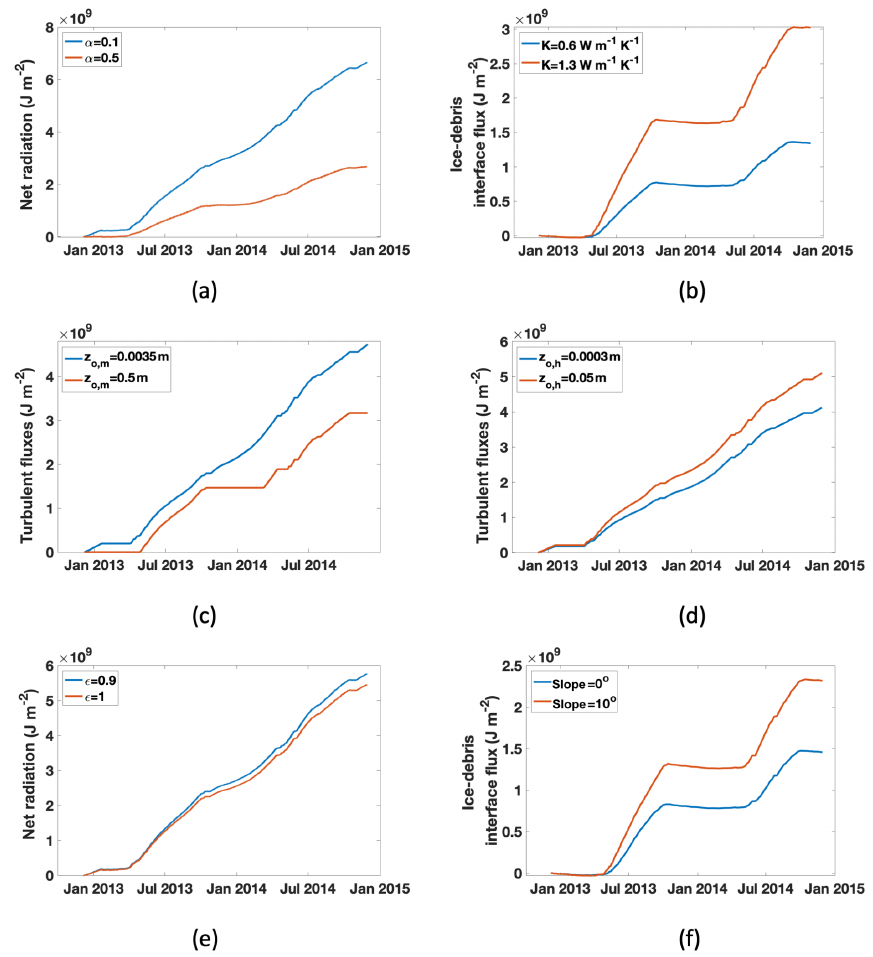
Figure 13. Cumulative energy fluxes most impacted by the six parameters perturbed through sensitivity tests, shown with the maximum and minimum tested values. Subfigure locations of Fig. S6